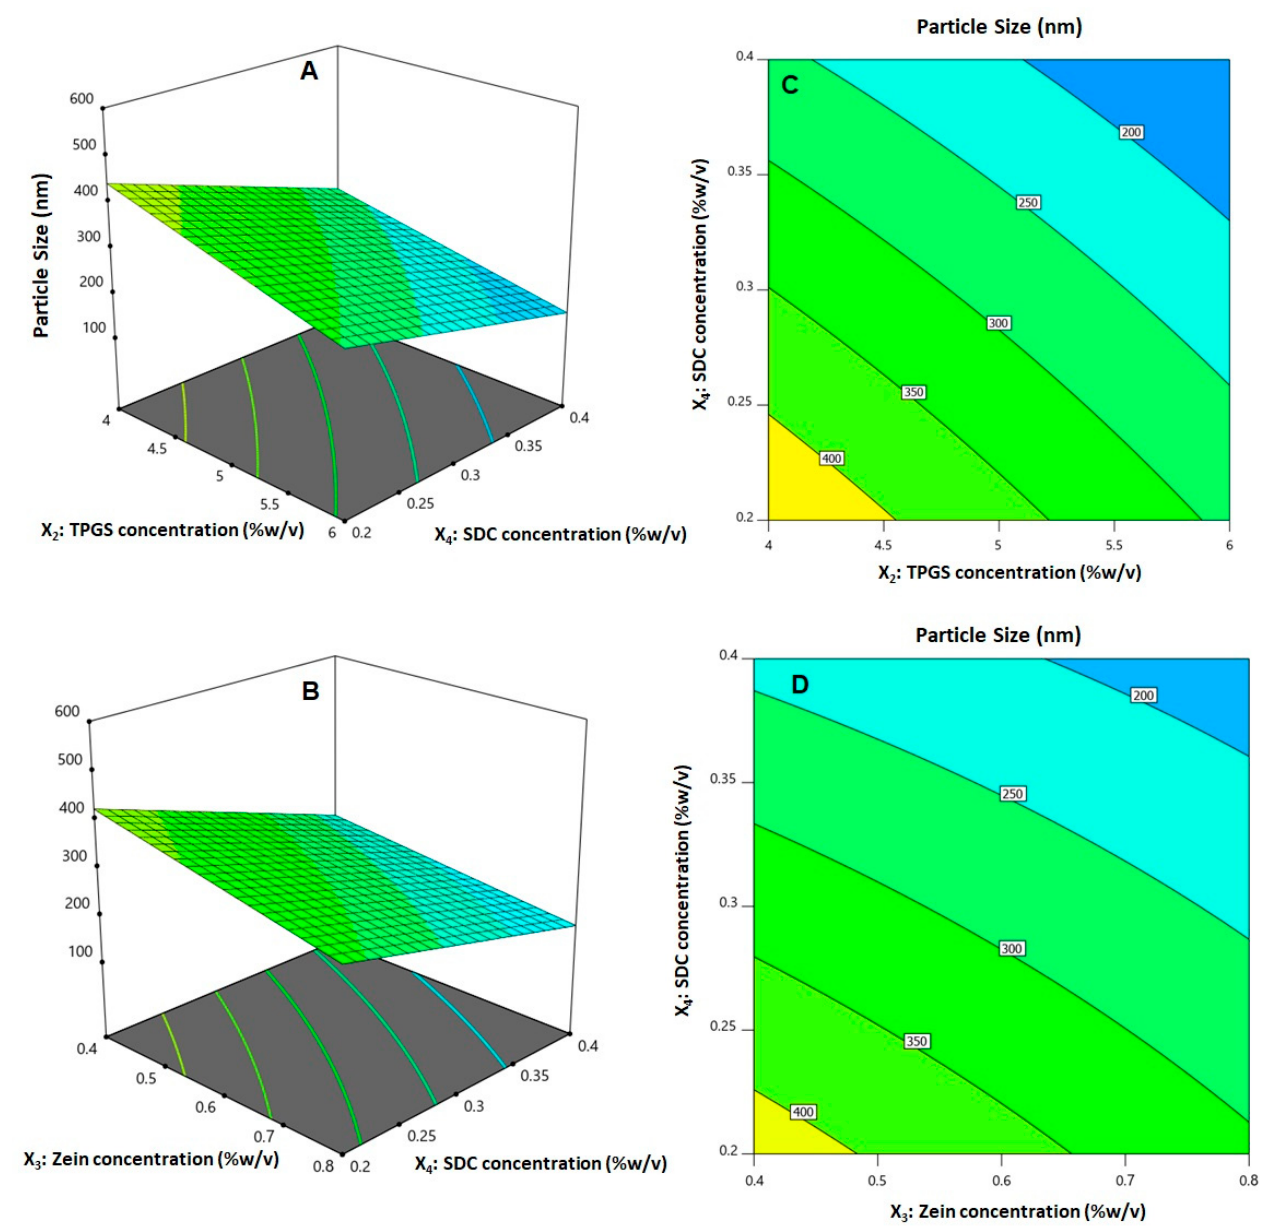
Figure 3. Response surface ( A , B ) and contour plots ( C , D ) indicating interaction between the signifi- cant factors on ICA–tocozeinolate nanosphere